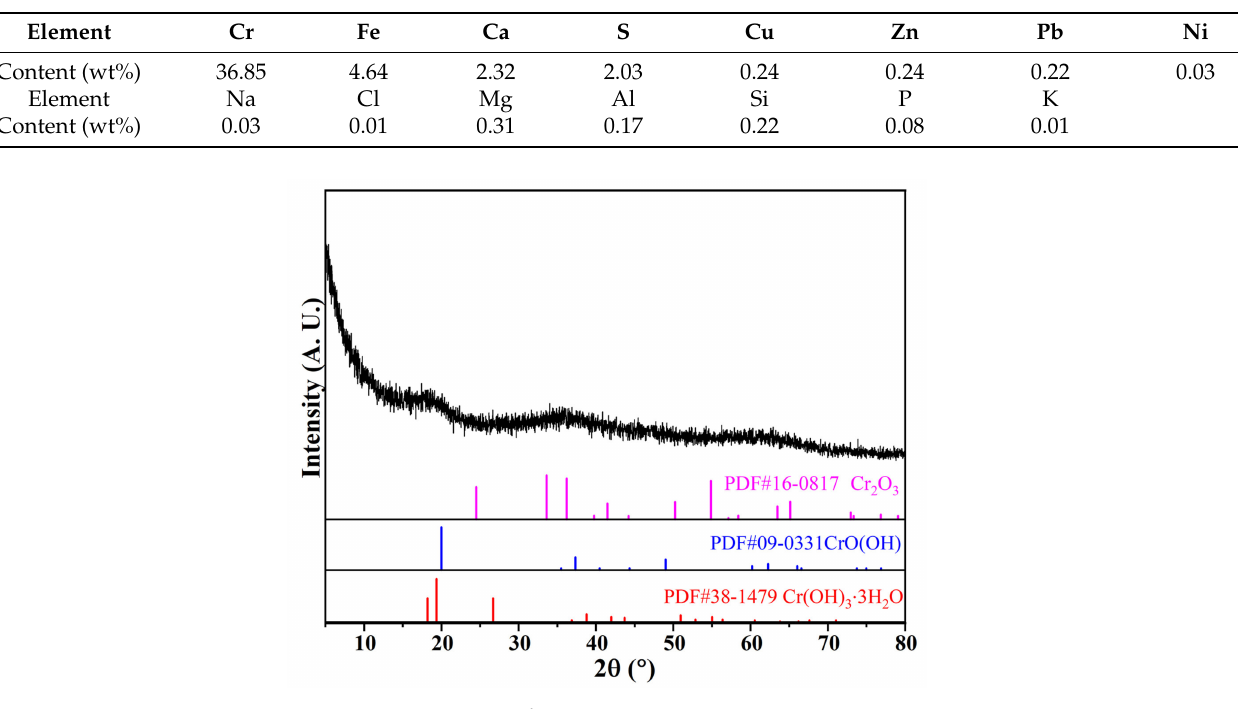
Figure 4. XRD pattern of CRES.